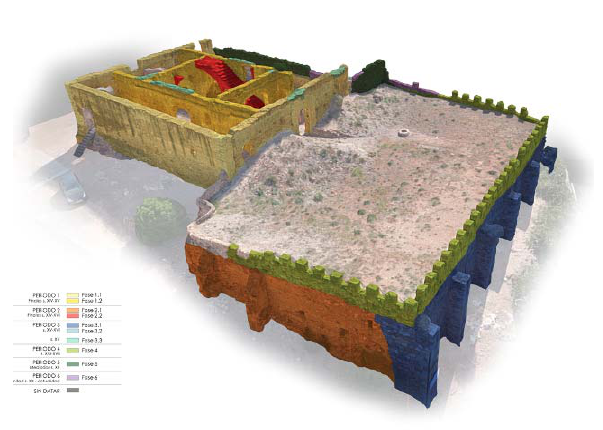
Fig. 5. Drone + scanner-lasser: 3D hypothesis of the relative